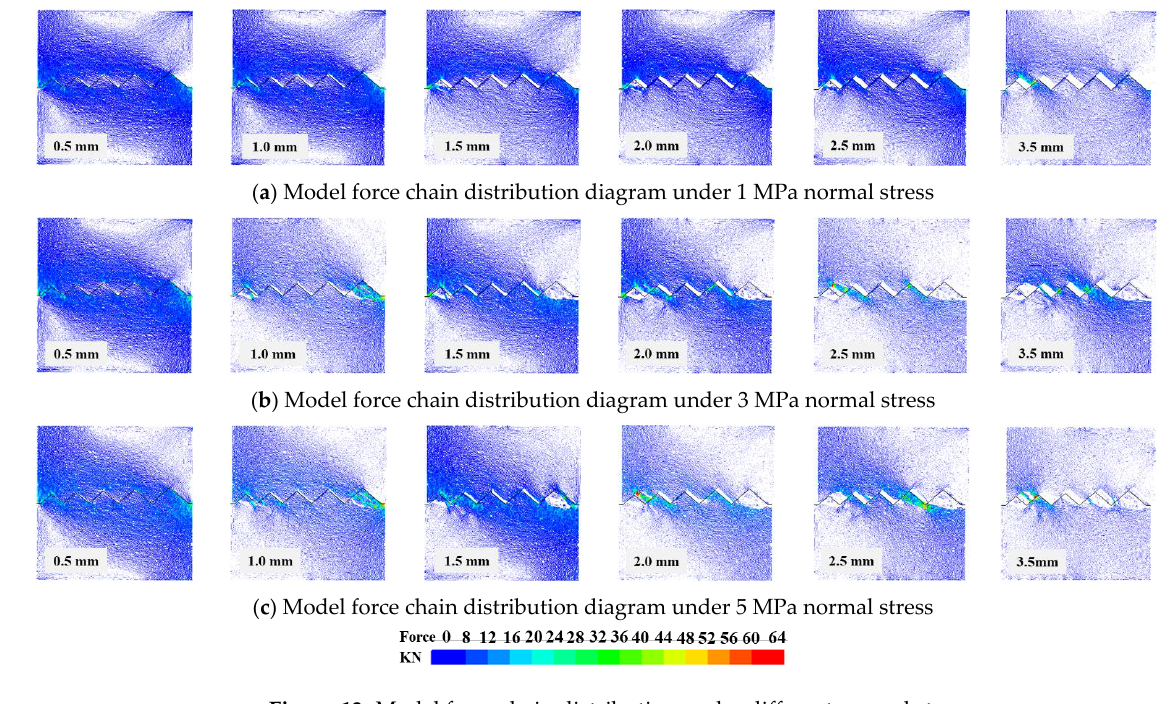
Figure 13. Model force chain distribution under different normal